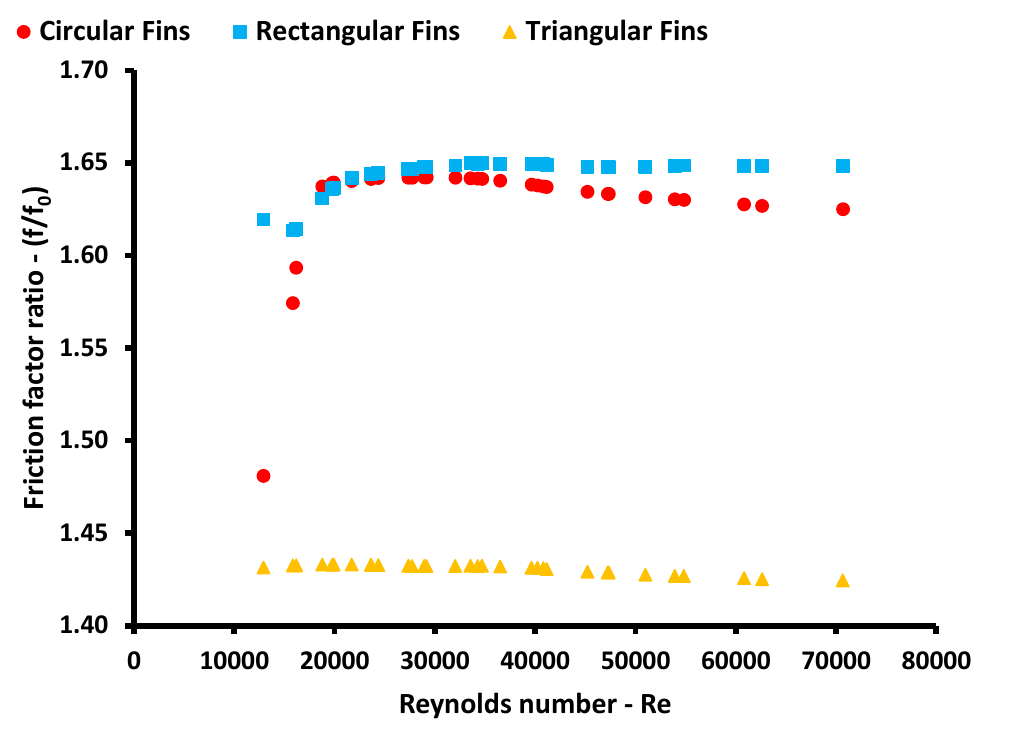
Figure 24. Friction factor ratio in the different examined operating conditions for the different finned tubes.